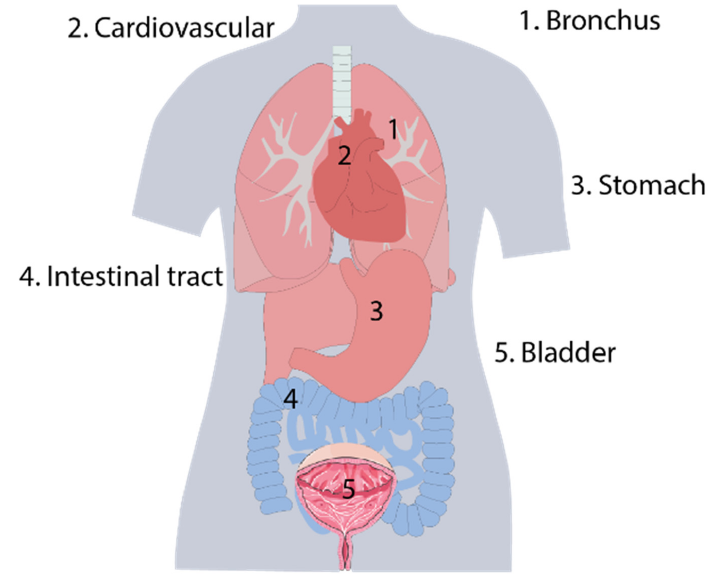
Figure 1. Typical lumens or cavities of humans.